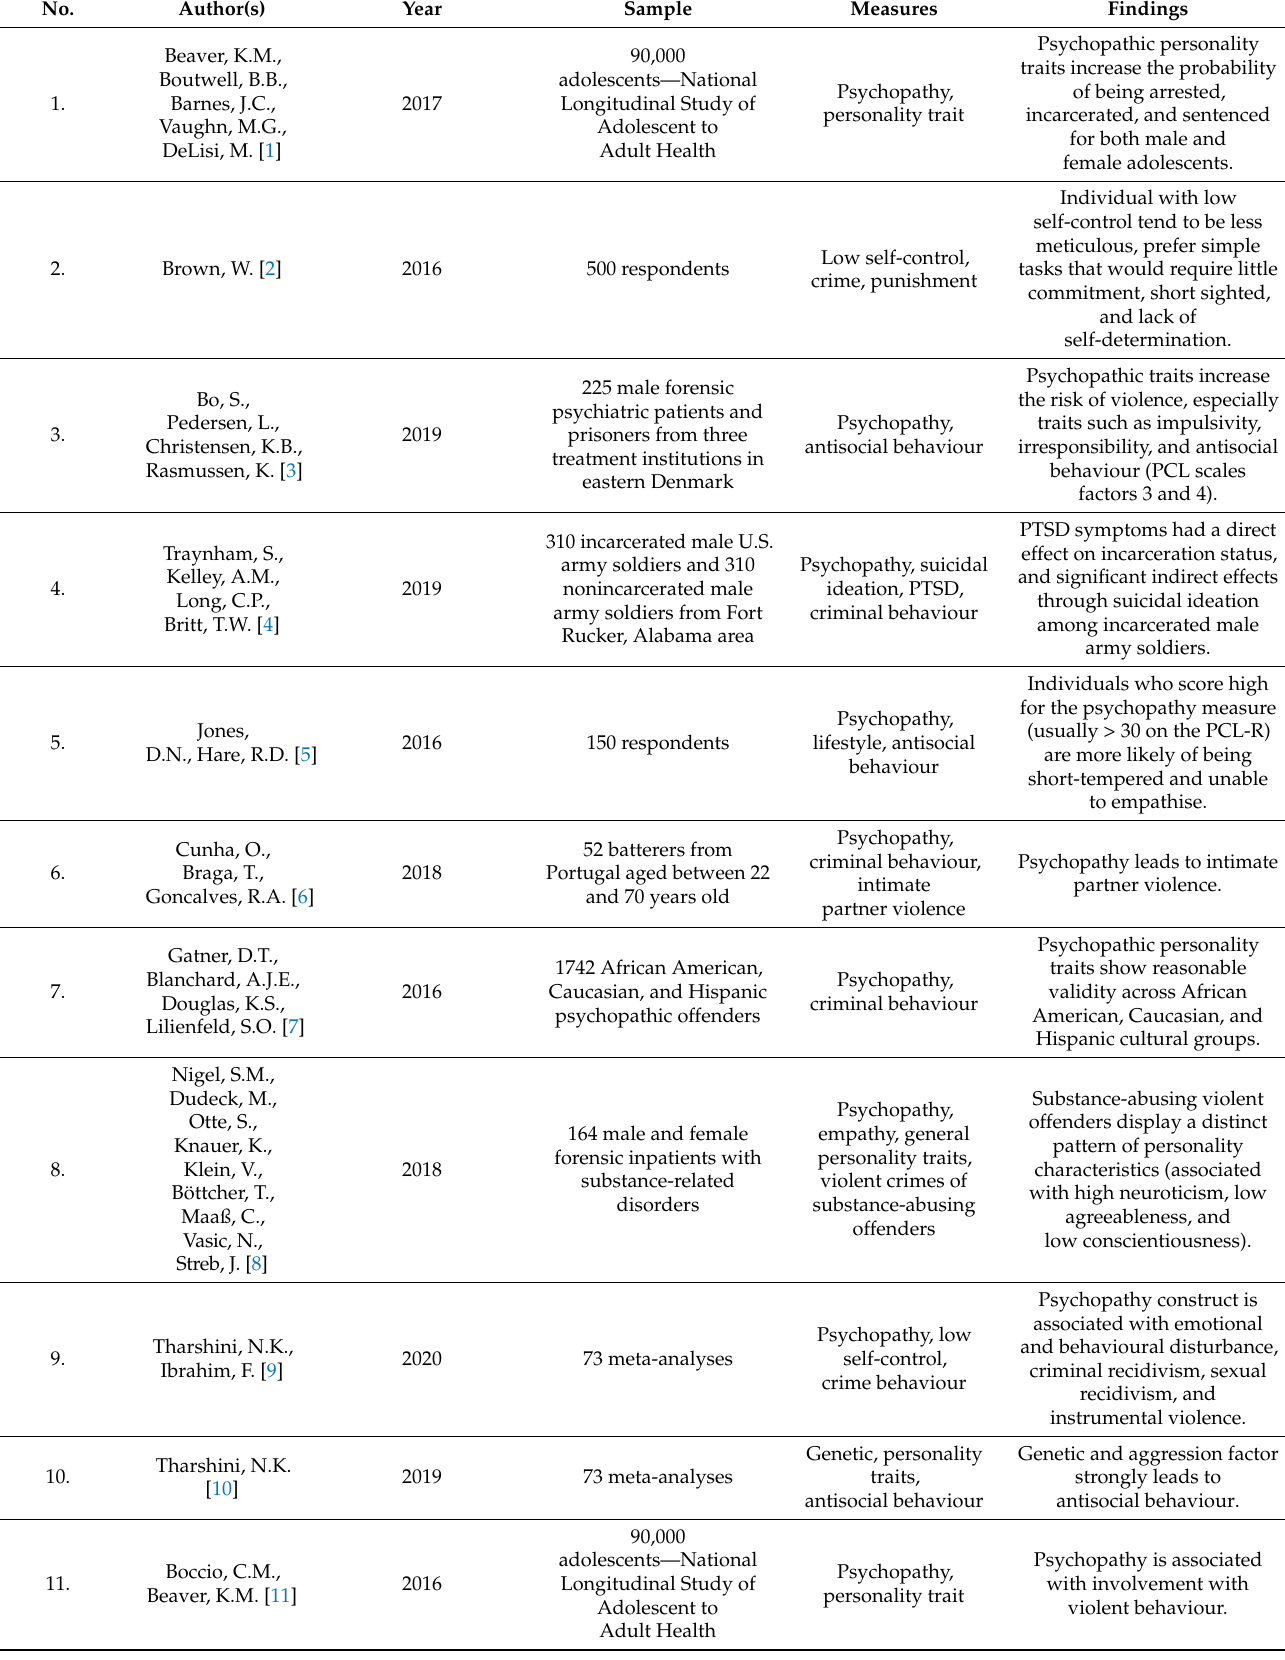
Table 1. Summary of